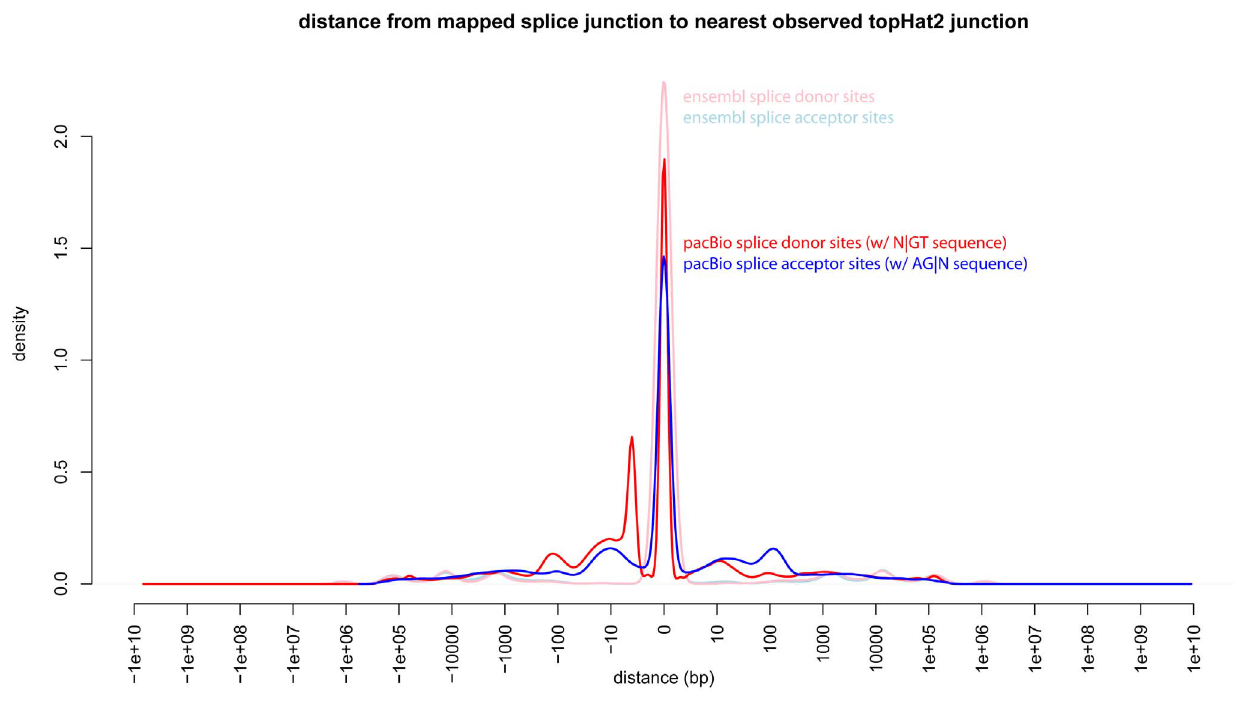
Figure 3. Validation of mapped long-read splice sites. TopHat2 was used to identify observed splice junctions from the short-read data. The light red and light blue lines show the distribution of distances from Ensembl-annotated splice sites to the experimentally observed splice sites. Both of these lines peak heavily at 0 indicating the degree of agreement between these orthogonal datasets. Splice sites annotated from long-read sequencing (blue and red), also show overall agreement, with a small peak of misidentified splice donor sites within 10 bp of the accurate one, which is possibly due to alignment errors near sites with multiple possible splice donor sites.